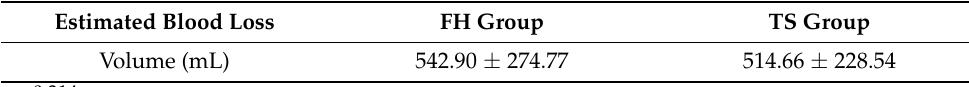
Table 2. Estimated blood loss by hemoglobin balance formula.